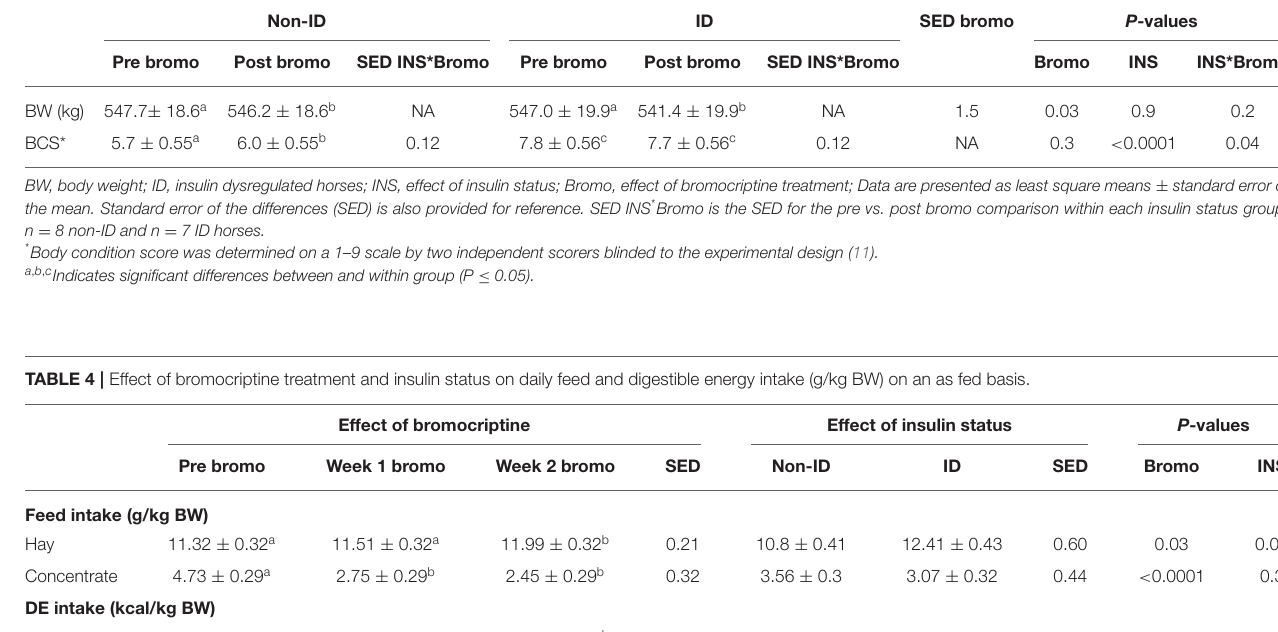
TABLE 3 | Changes in body weight and body condition score following bromocriptine treatment in ID and non-ID horses.